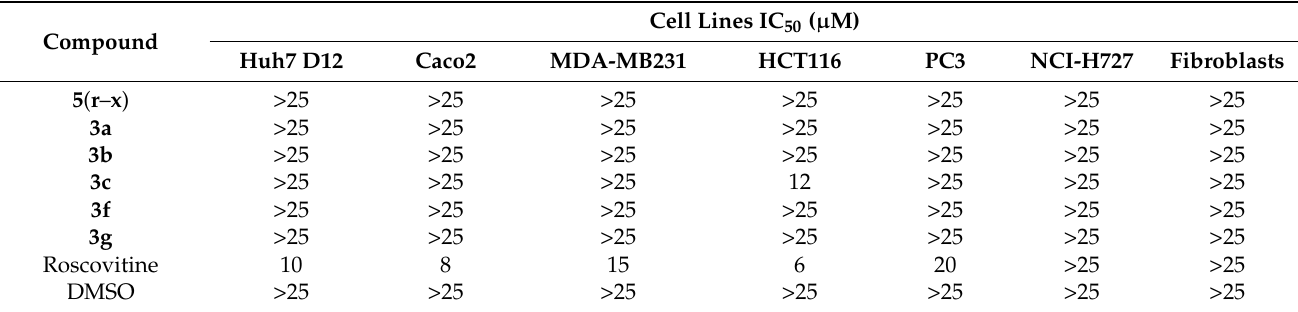
Table 6. Effects of the (5 Z ) 2-amino-5-arylidene-1,3-thiazol-4(5 H )-one derivatives 5r – x a and (5 Z ) 5-arylidene-2-thioxo-1,3- thiazolidin-4-one 3a – c , 3f , g derivatives b on six representative tumoral cell